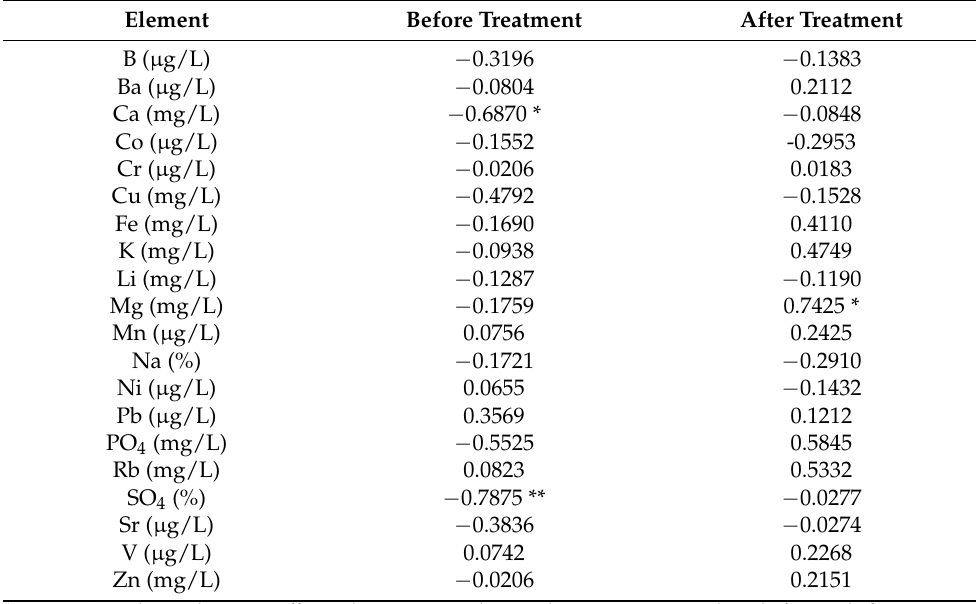
Table 2. Spearman’s rank correlations coefficient between sera elemental concentrations and age before and after treatment.